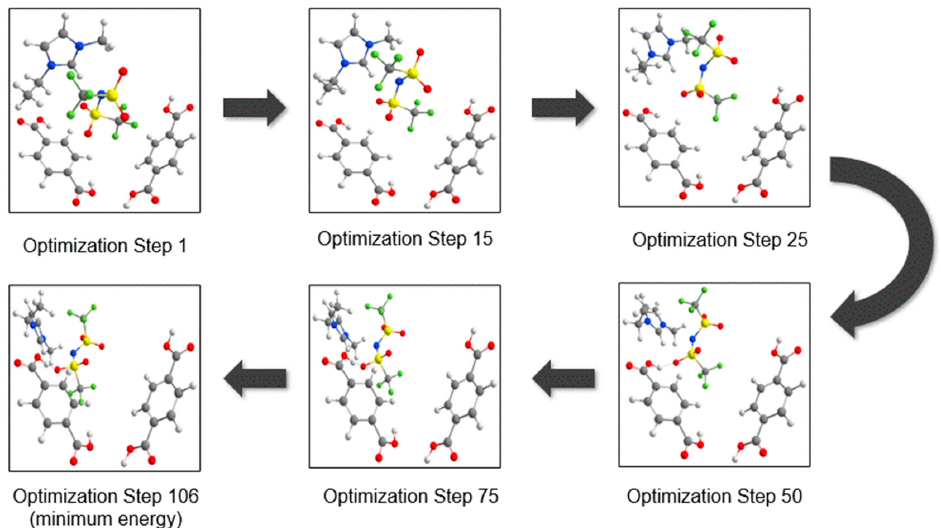
Figure 16. The geometry optimization process of UiO-66 (organic linkers) and [EMIM][TFSI]. The IL was initially placed at the center of the organic linkers, and eventually, the IL was taken to the terminated oxygen.